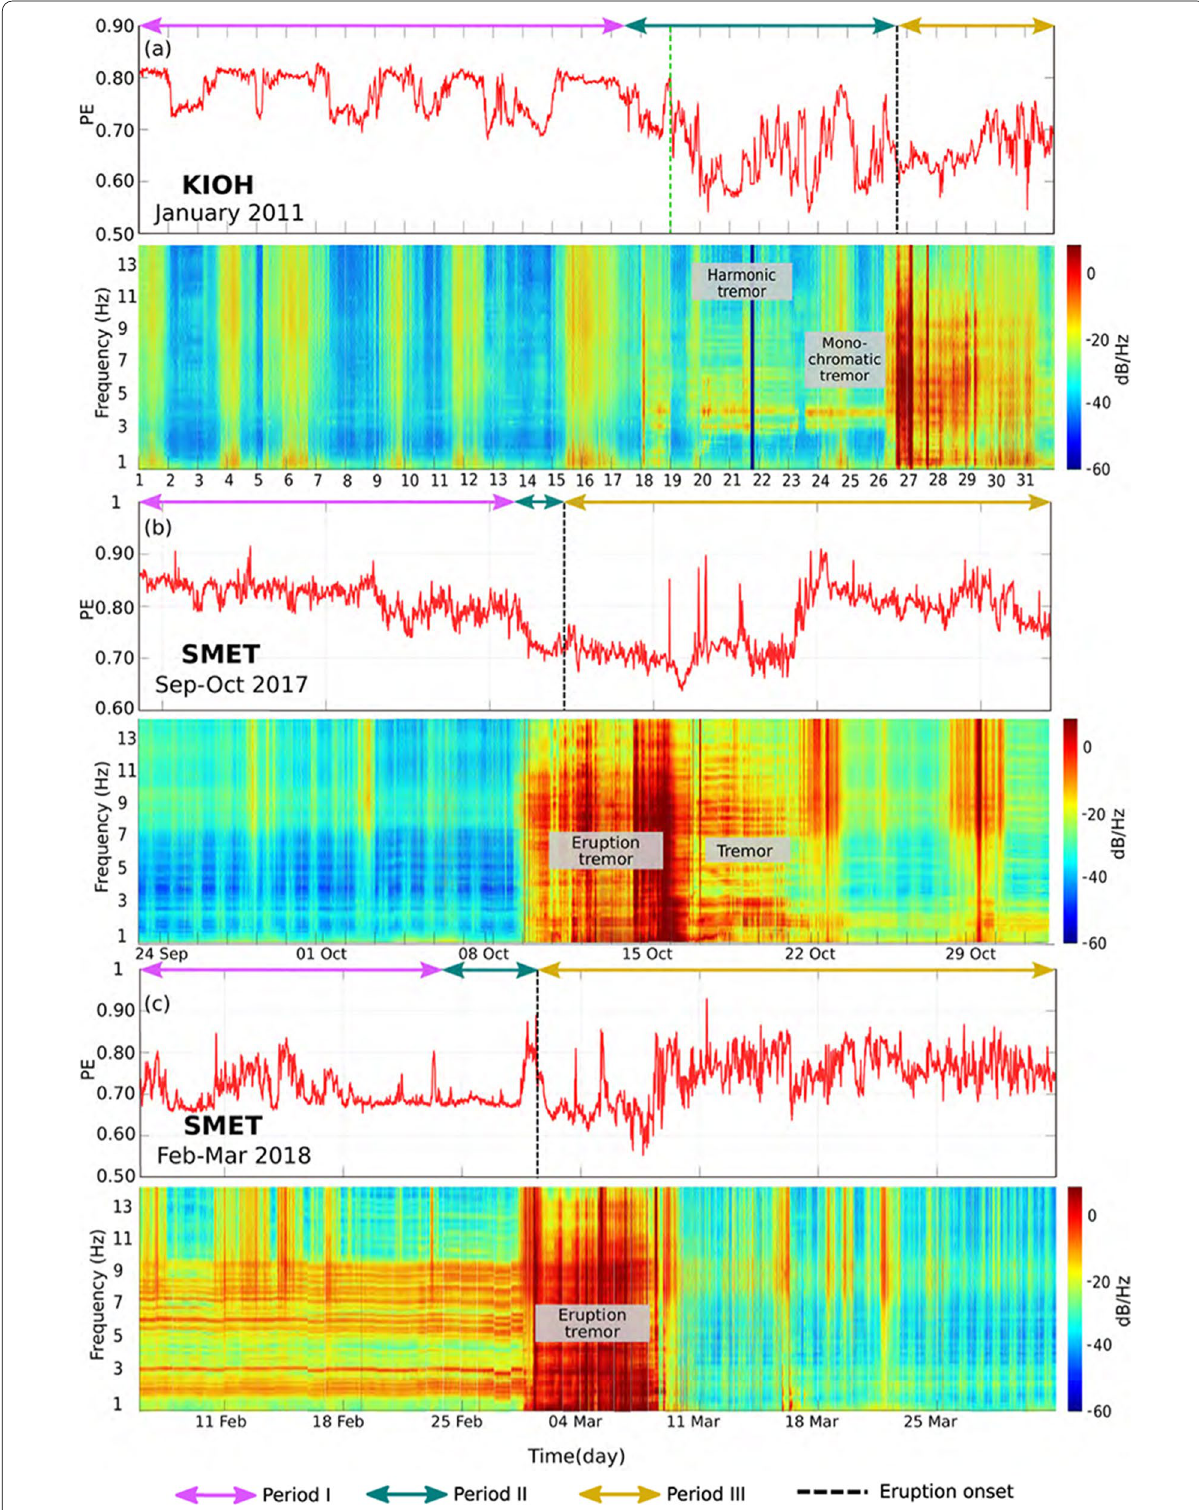
Fig. 4 Same as in Fig. 2 for station KIOH (active only during the 2011 eruption) and for station SMET (active during both 2017 and 2018 eruptions). All other symbols are the same as in Fig.